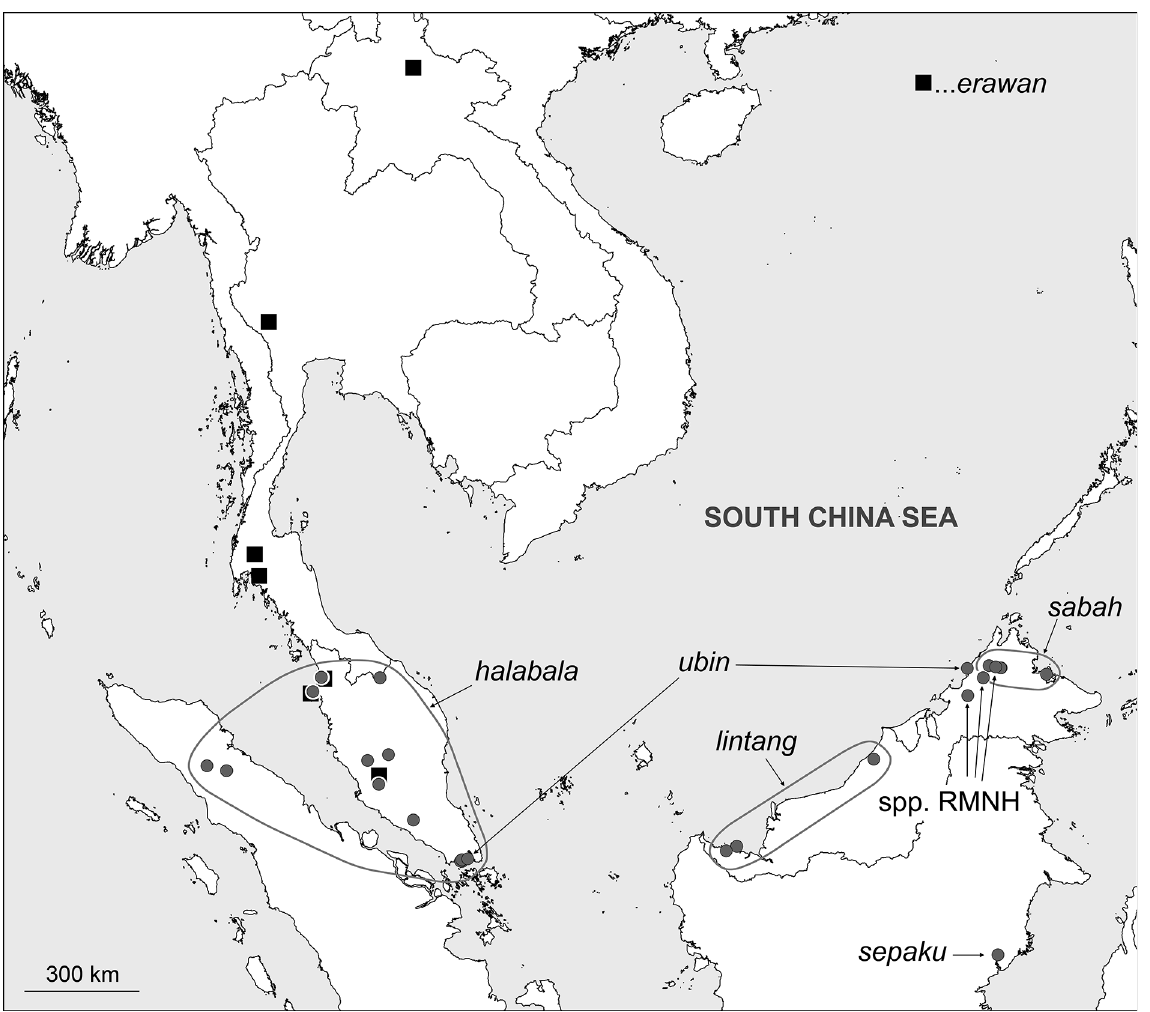
Fig. 17. Known distribution of the core group of the Pholcus halabala species